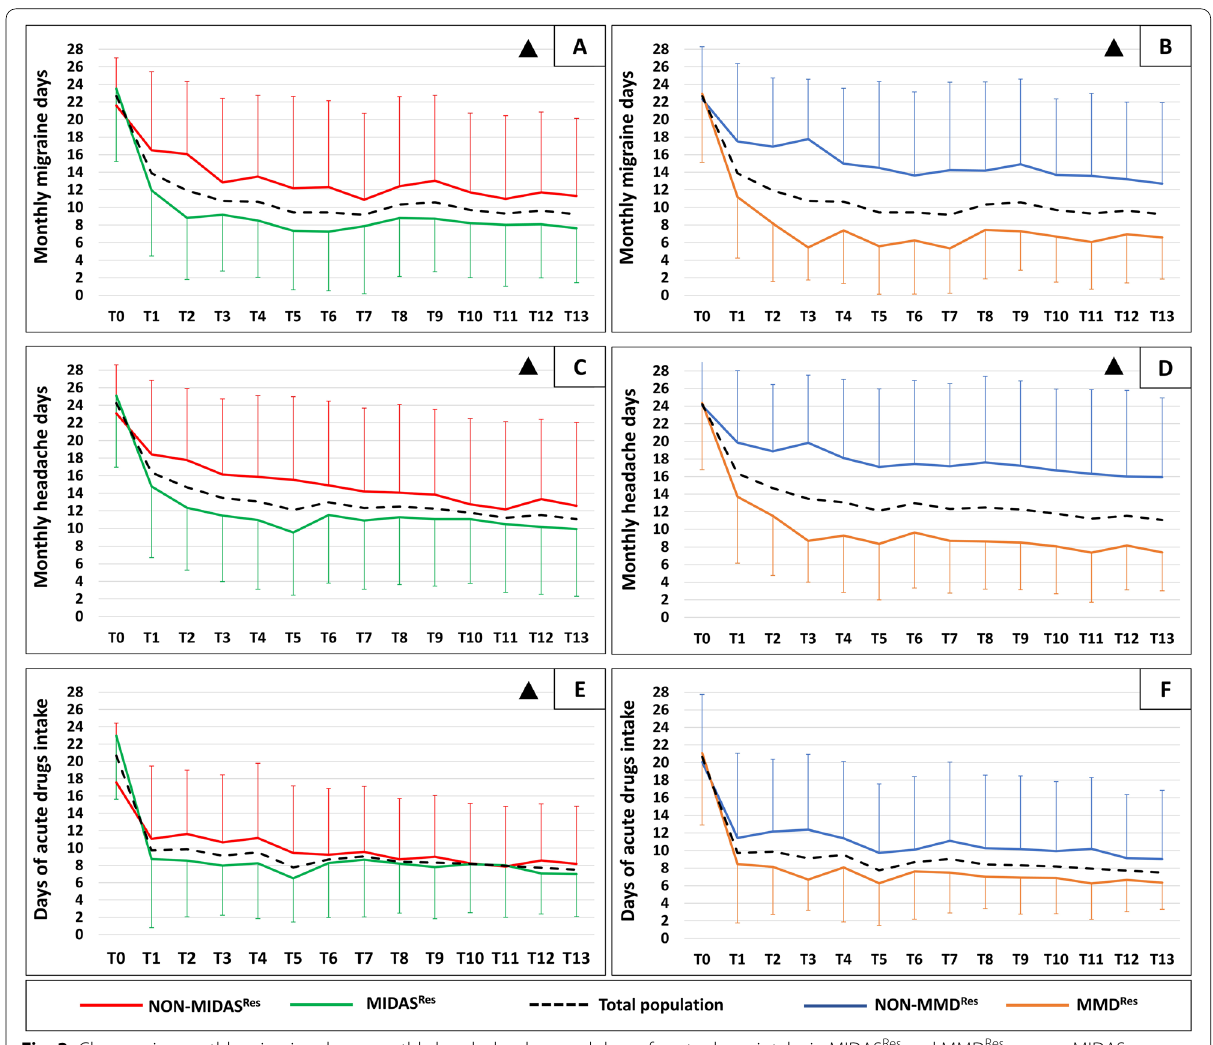
Fig. 3 Changes in monthly migraine days, monthly headache days, and days of acute drugs intake in MIDAS Res and MMD Res groups. MIDAS: MIgraine Disability Assessment. MIDAS Res (green lines): Patients with a MIDAS score reduction of at least 50% at T3. NON-MIDAS Res (red lines): Patients with a MIDAS score reduction < 50% at T3. MMD Res (orange lines): Patients with a MMDs reduction of at least 50% at T3. NON-MMD Res (blu lines): Patients with a MMDs reduction < 50% at T3. Black dotted lines represent changes in the overall study population. Δ: TIMExGROUP interaction < 0.050. Statistical analysis was performed with a non-parametric test for repeated measures, with the following factors: TIME: changes in the overall study population across the 1-year treatment period; GROUP: overall difference between study groups; TIMExGROUP interaction: different behavior of study groups across the 1-year treatment period. A : difference in monthly migraine days between MIDAS Res and NON-MIDAS Res groups. TIME p < 0.001, GROUP p 0.034, TIMExGROUP p 0.045 . B : difference in monthly migraine days between MMD Res and = = = = = NON-MMD Res groups.